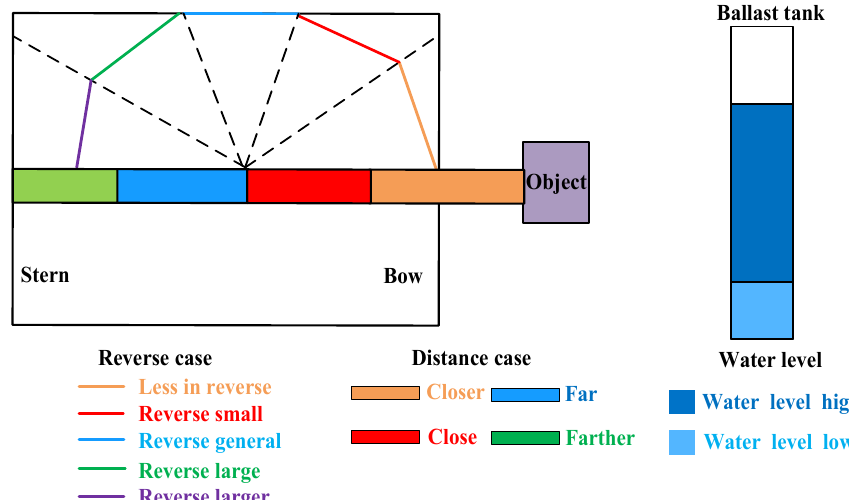
L i Figure 6. Schematic diagram of the reasoning decision variables under a certain working condition. ψ i is the angle between the lifting cargo and the ballast tanks; L i is the distance between lifting cargo and the ballast tanks. According to the expert experience, the angle between the lifting cargo and the ballast tanks can be classified into five categories. Then, these five categories can be formulated into five fuzzy sets as shown in Figure 7. The corresponding linguistic labels are as fol- lows: less in reverse, reverse small, reverse general, reverse large and reverse larger. The distance between the lifting cargo and the ballast tanks can be classified into four fuzzy sets, i.e., closer, close, far and farther. The water level can be classified into two fuzzy sets, i.e., water level high and water level low. The membership function of each fuzzy set and